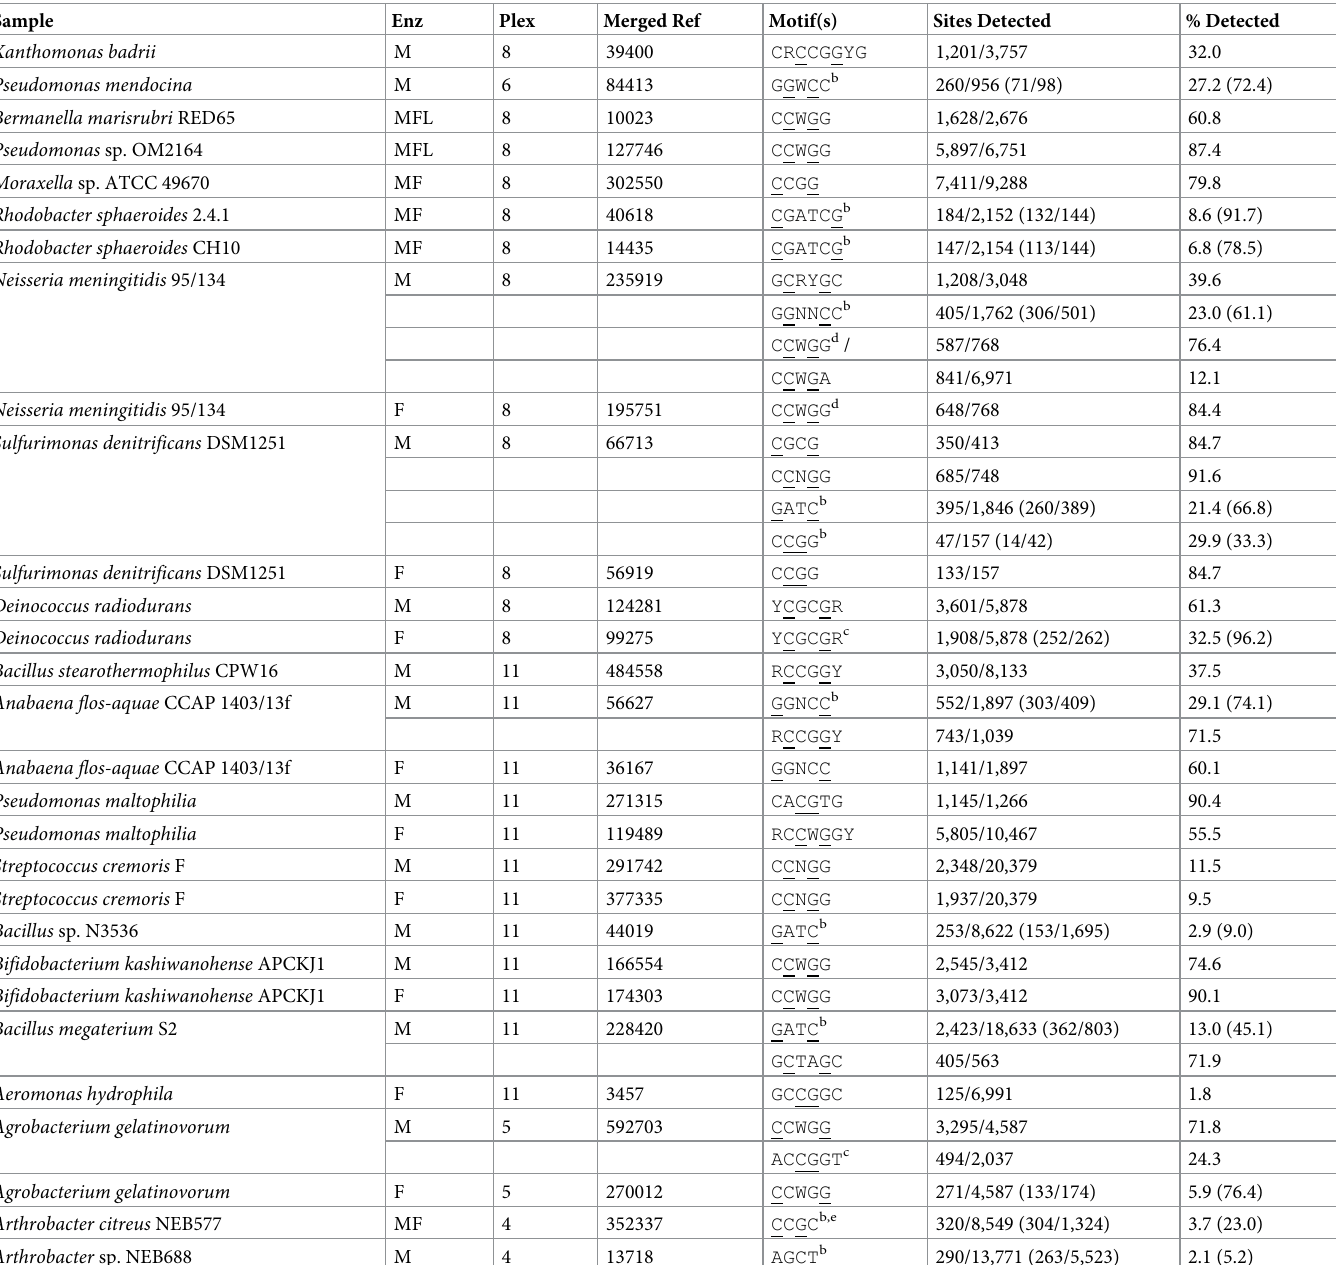
Table 7. Motifs determined using the Ion Torrent platform a